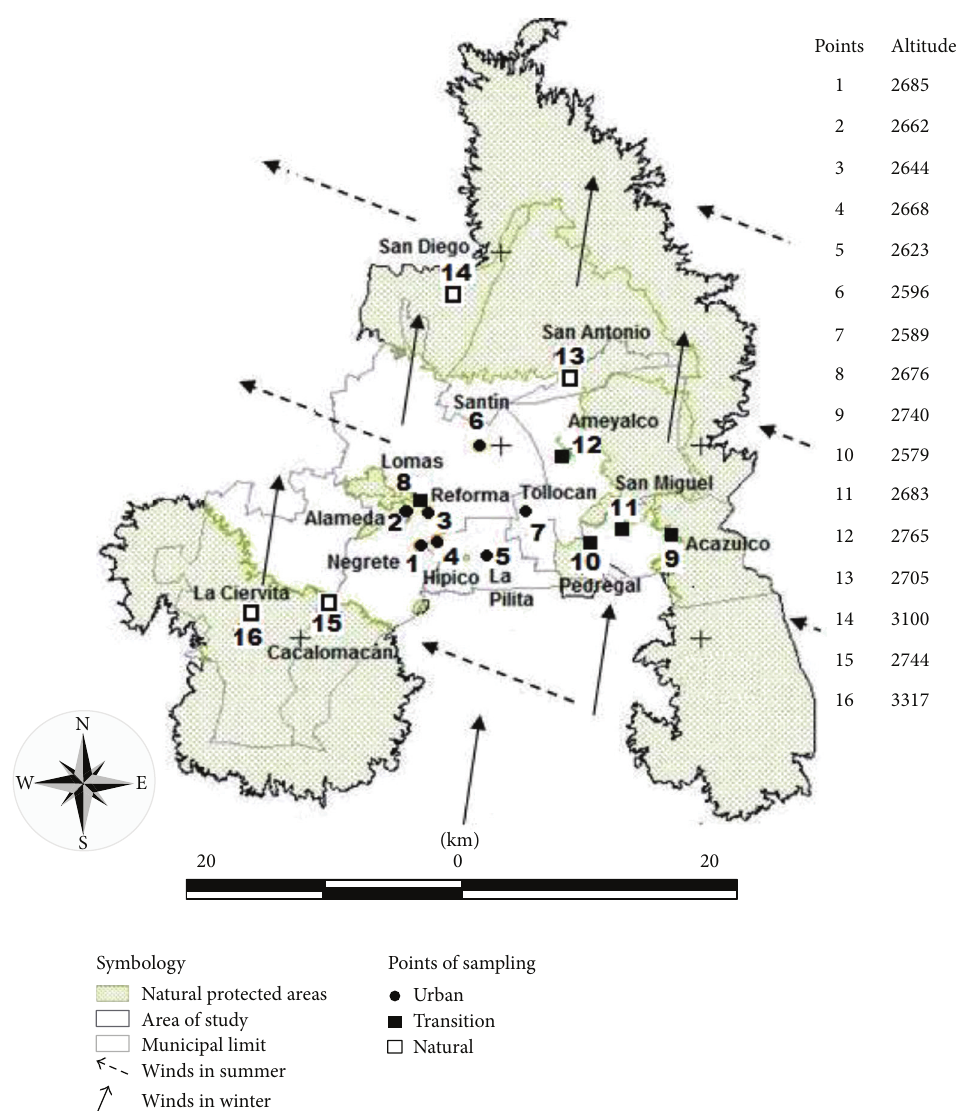
Figure 1: Sampling sites, wind directions, and altitudes in the